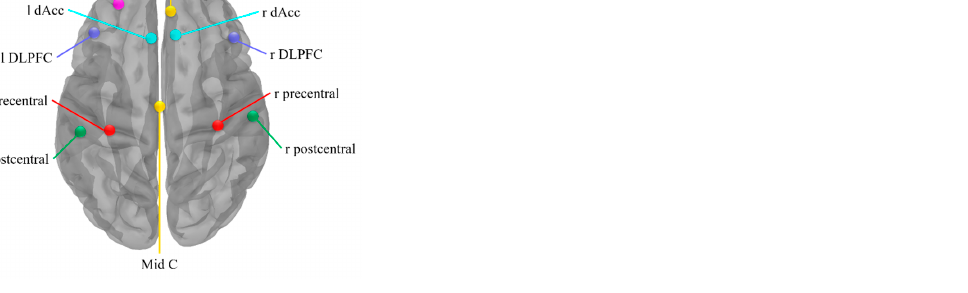
Figure 2. Schematic of the source montage used in calculating PLV. Abbreviations: Mid F, mid frontal cortex; r SF, right superior frontal; l SF, left superior frontal; r dAcc, right dorsal anterior cingulate cortex; l dAcc, left dorsal anterior cingulate cortex; r DLPFC, right dorsal lateral prefrontal cortex; l DLPFC, left dorsal lateral prefrontal cortex; Mid C, mid-central cortex; l precentral, left precentral cortex; l postcentral, left postcentral cortex; r precentral, right precentral cortex; r postcentral, right postcentral cortex.